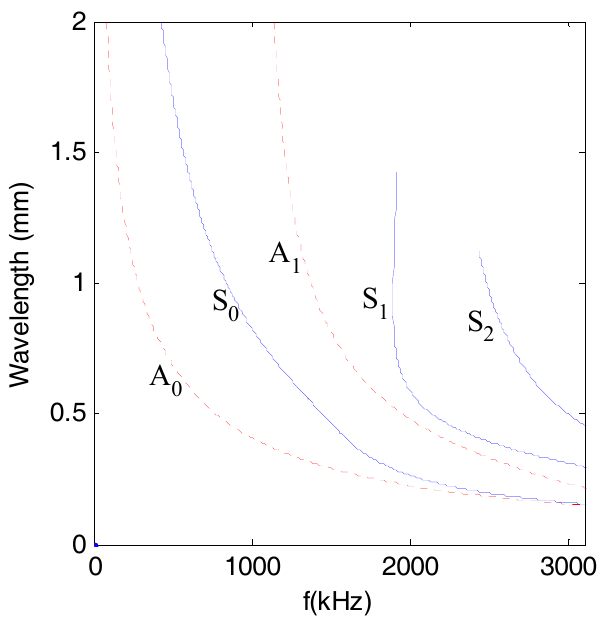
Figure 2. Dispersive curve of wavelength (Alloy 5052, half-depth h = 0.75 mm).